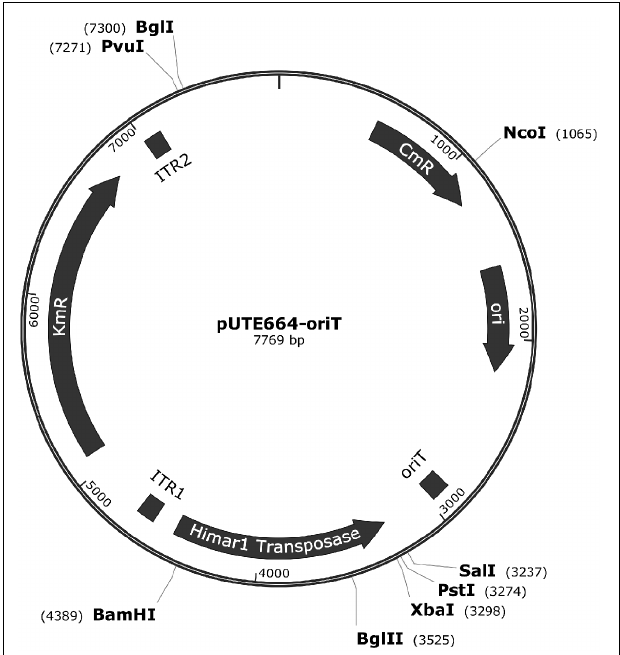
FIGURE 1 | Vector map of pUTE664-oriT. This plasmid contains a functional mariner inverted terminal repeat (ITR) with kanamycin (Km) resistance cassette, and a backbone vector including a hyperactive Himar1 transposase. ori, replication origin of plasmid in E. coli ; oriT, transfer function; Km R , kanamycin resistant gene; Cm R , chloramphenicol resistant